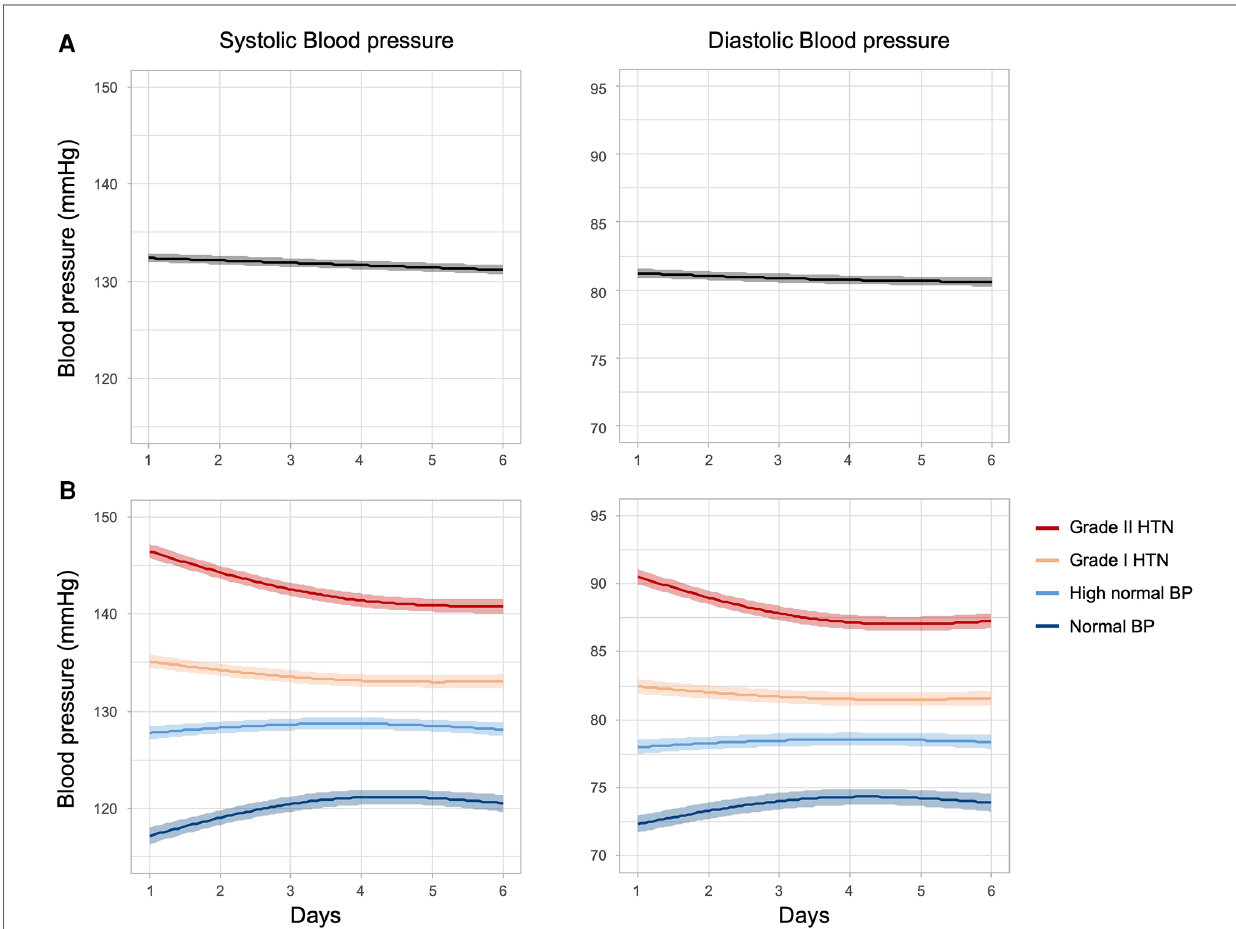
FIGURE 2 Home blood pressure values in the fi rst HBPM interval. Shown are plots of predicted smoothing spline functions of time (solid lines) with 95% con fi dence bands (matt surrounding). ( A ) Course of systolic and diastolic blood pressure values of users with self-reported hypertension in the fi rst HBPM period. ( B ) Course of SBP and DBP strati fi ed by initial (day 1) BP category. Smooth functions for systolic BP as a function of time show signi fi cant non-linear relationships (normal BP: EDF=1.98, p <2×10 − 16 ; high normal BP: EDF=1.91, p =5.4×10 − 3 ; grade I HTN: EDF=1.91, p <2×10 − 16 ; grade II HTN: EDF=1.98, p <2×10 − 16 ) as well as the diastolic BPs (normal BP: EDF=1.97, p <2×10 − 16 ; high normal BP: EDF=1.85, p =1.8×10 − 2 ; grade I HTN: EDF=1.88, p =1.6×10 − 5 ; grade II HTN: EDF=1.99, p <2×10 − 16 ). The observed EDFs identical or close to 2 indicate a parabolic relationship in